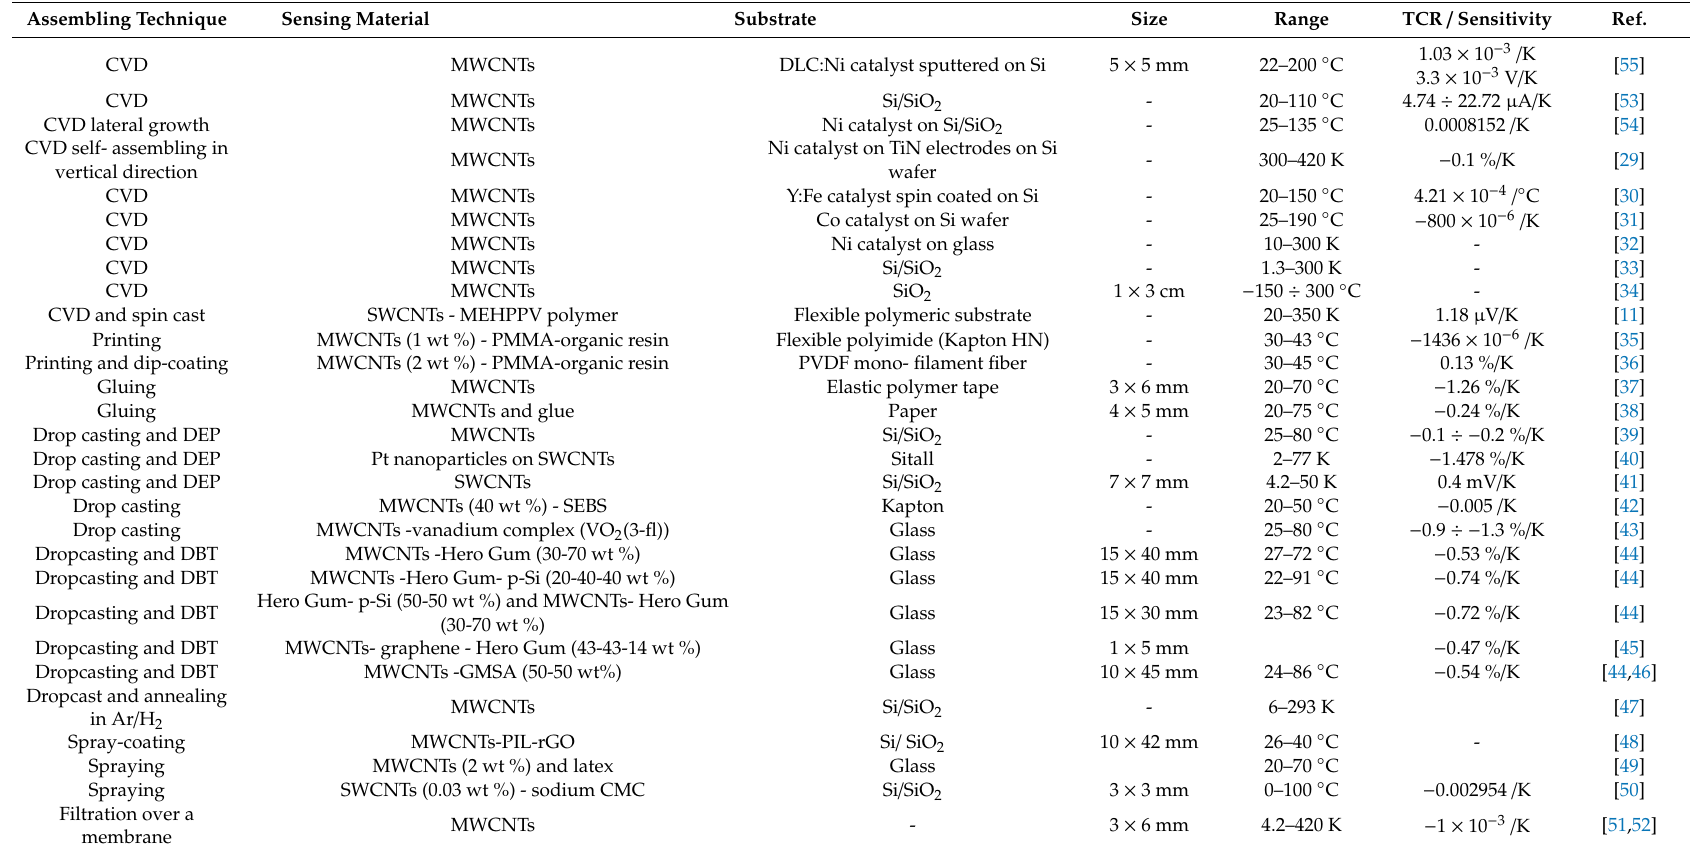
Table 2. CNT-based temperature sensor